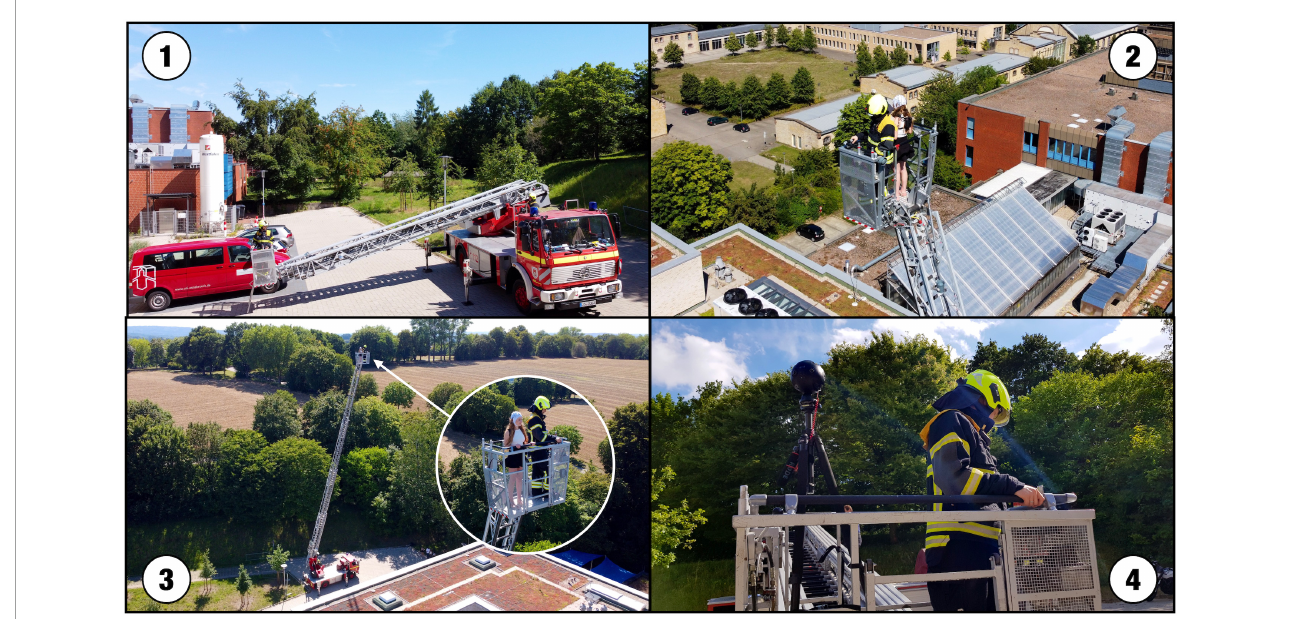
FIGURE1 Photographs from the real-life setting: (1) Basket on the ground at the starting point. (2) Basket with firefighter and participant declining. (3) Basket at a maximum height of 33 m/108 feet. (4) Basket on the ground with firefighter and Insta 360 Pro VR camera instead of a participant. Photos taken by